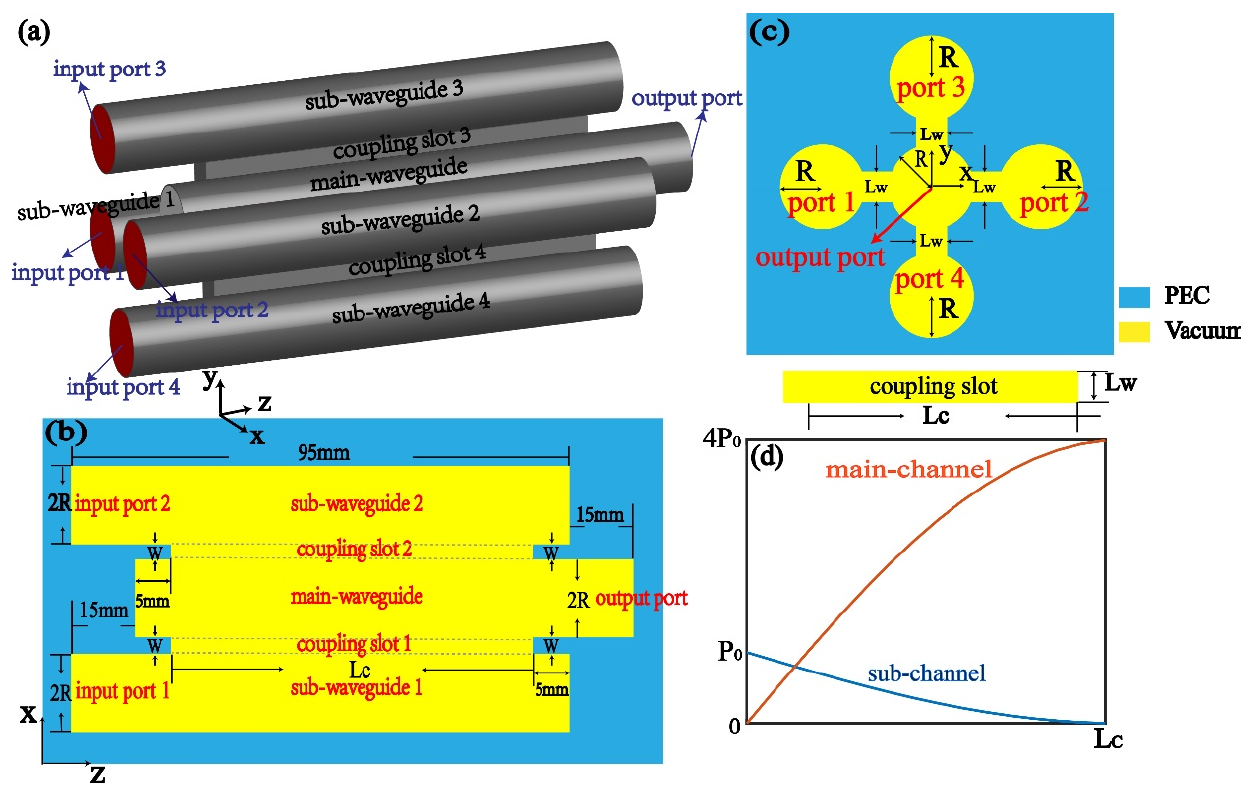
Figure 5. ( a ) Combiner 3D structure, ( b ) longitudinal structure view, ( c ) transverse structure view, and ( d ) theoretical power variation.